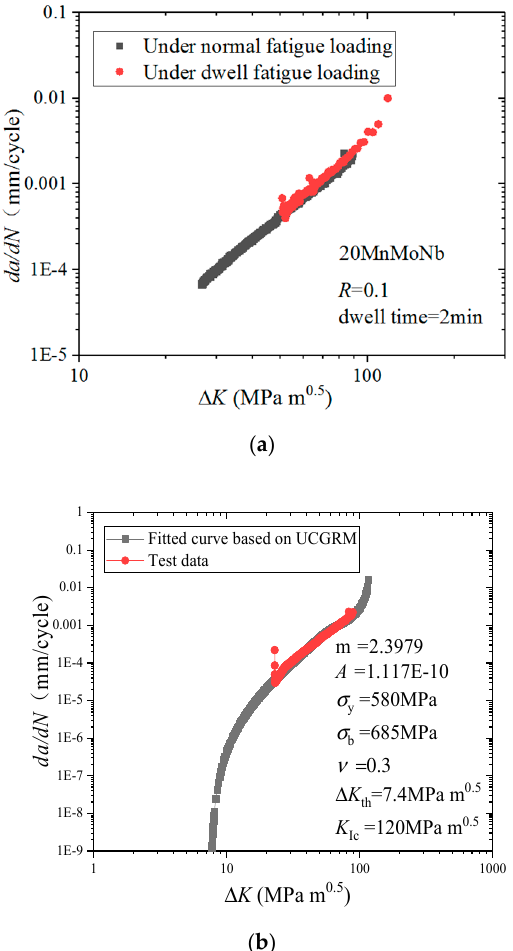
Figure 10. ( a ) Crack growth rate curves (da / dN~K curve) under normal fatigue loading (triangular load history) and dwell fatigue loading (trapezoidal load history); ( b ) crack growth rate curve simulated by UFLP with model parameters [56].